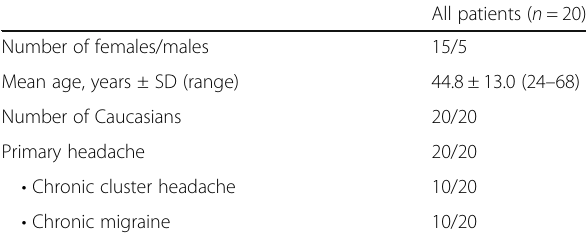
Table 1 Demographics of the sample